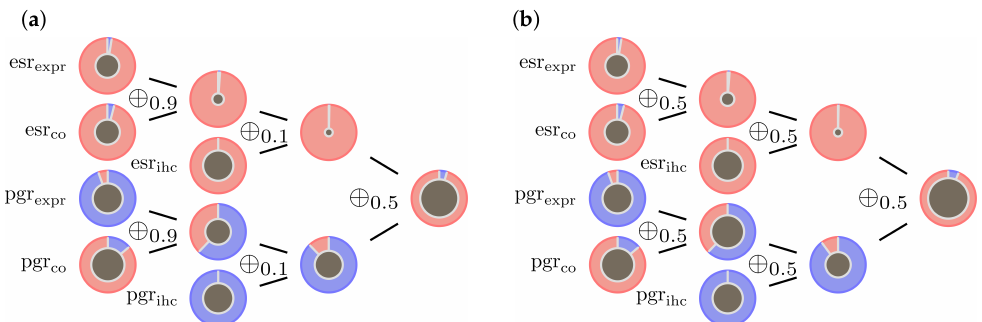
Figure 7. Contradicting data inducing uncertainty: ( a ) model (9) illustrated by a sample with very contradictory input data (sample id = 2365). ( b ) even when setting all λ = 0.5 in the ECRs no conclusive evidence is generated. Nevertheless, the influence of λ can change case by case.